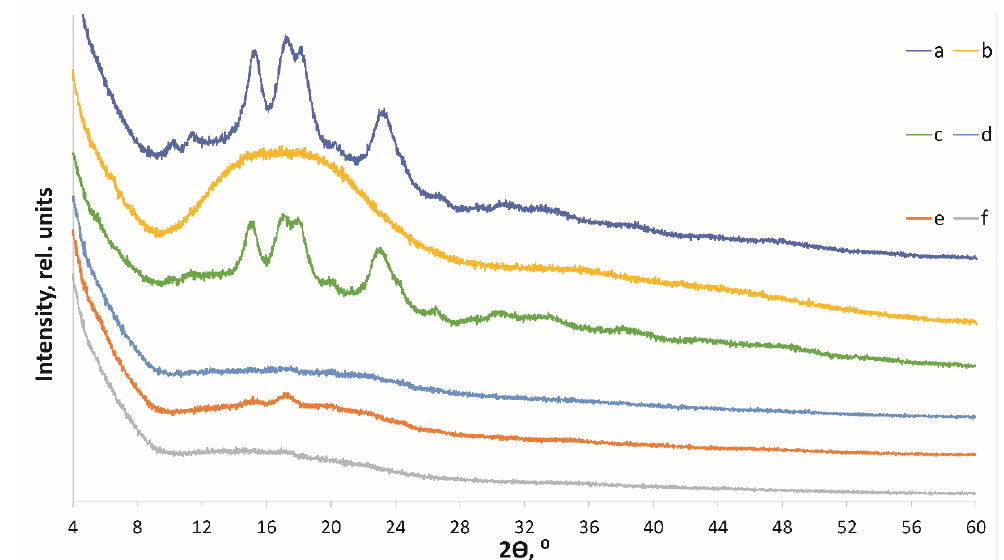
Figure 3. The XRD pattern of native tapioca starch ( a ); amorphous starch ( b ); nano-sized starch ( c ); native starch-based film ( d ); amorphous starch-based film ( e ); and nano starch-based film ( f ).